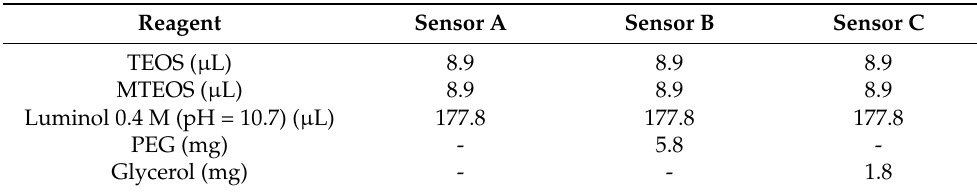
Table 2. Different mixtures tested in order to develop a luminol sensor. For all mixtures, 4.4 µ L of nanopure water was